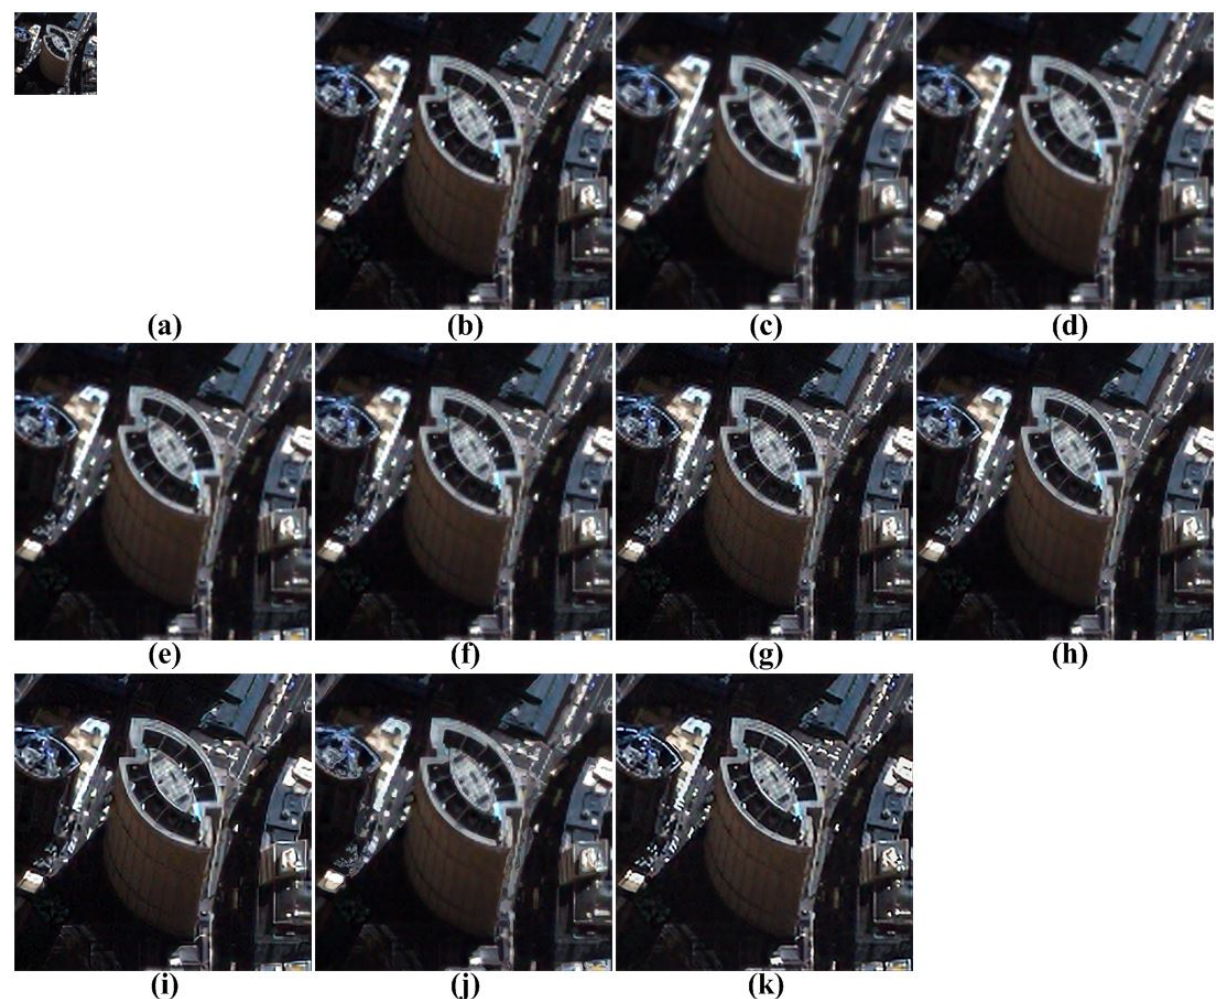
Figure 13. Results of resolution enhancement by enlarging a real UAV image: ( a ) original HR image in Figure 11b; result of: ( b ) cubic-spline interpolation [3]; ( c ) interpolation-based SR [4]; ( d ) interpolation-based SR [5]; ( e ) interpolation-based SR [6]; ( f ) example-based SR [7]; ( g ) patch-based SR [9]; ( h ) patch-based SR [10]; ( i ) patch-based SR [11]; ( j ) patch-based SR [12] and ( k ) the proposed